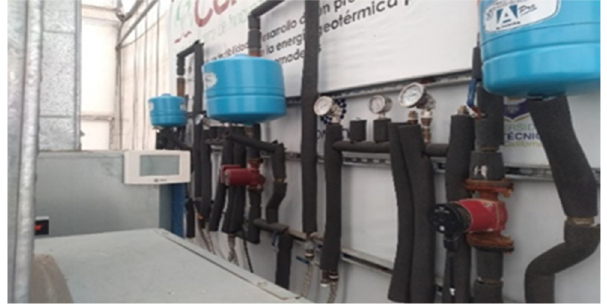
Figure 1. Geothermal heat pump hydraulic system installation in the greenhouse.